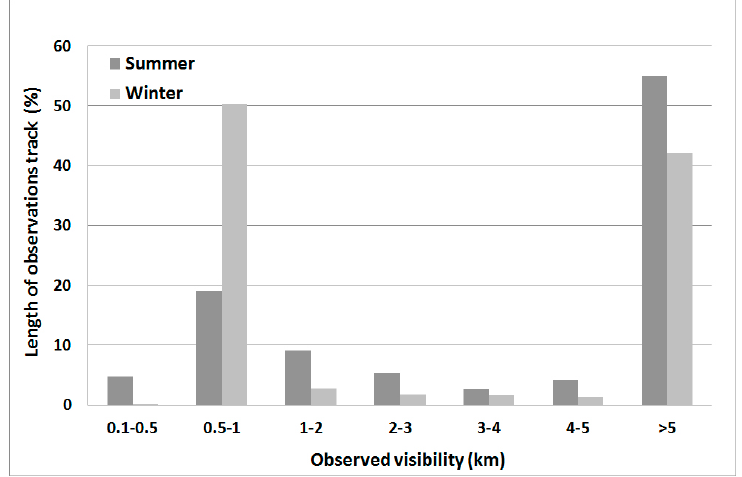
Figure 3. Schematic illustration of matching the ship and the satellite microwave SIC data.